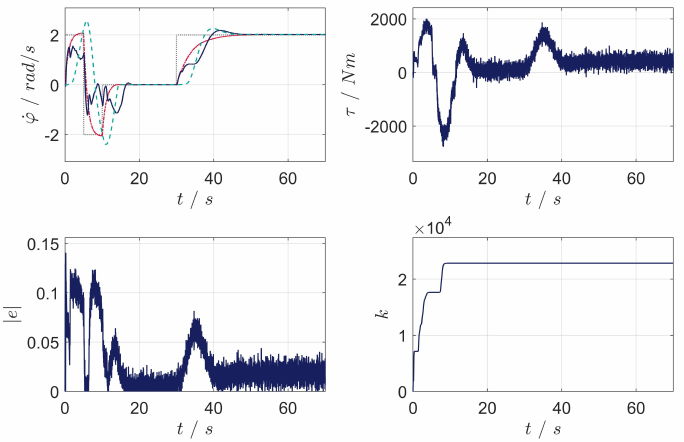
Figure 14. Transient responses of the closed-loop system. Adaptation and angular velocity reference tracking in presence of the measurement noise: ˙ ϕ 0 (solid blue), ˙ ϕ L (dashed green), ˜ y (dash-dot red) and r (dotted